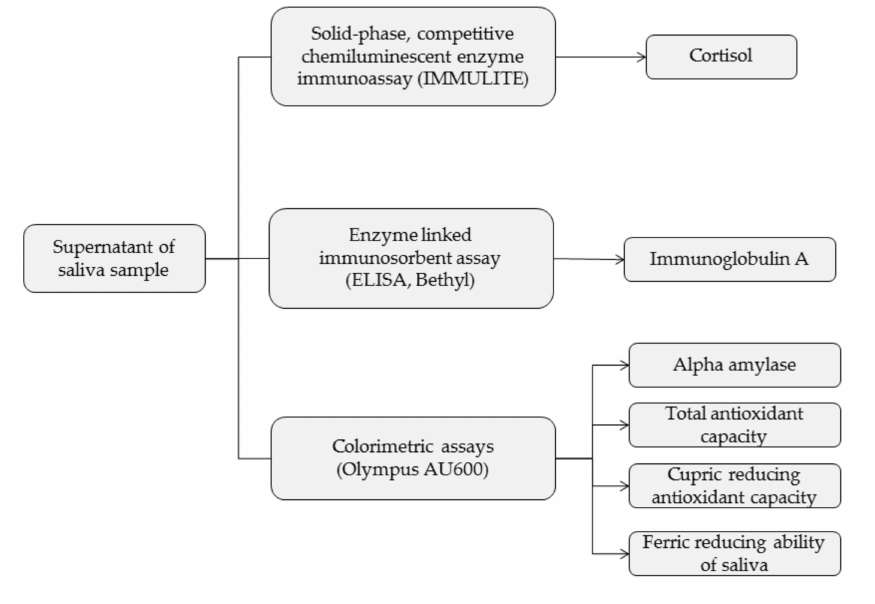
Figure 3. Flow of procedures of an individual